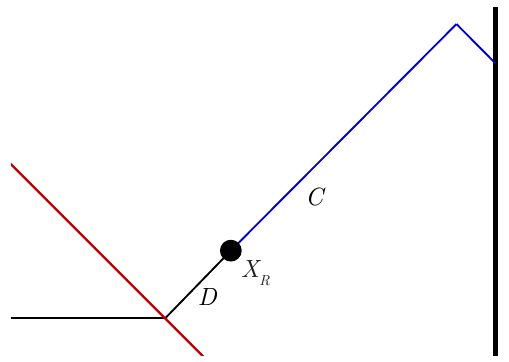
Figure 9 . Breaking up the right interval and left intervals into null components for the calculation of the change in the entropy of X R with variations along y (cid:0) . The red line is the shell. the di(cid:11)erence in the expansion along y (cid:0)